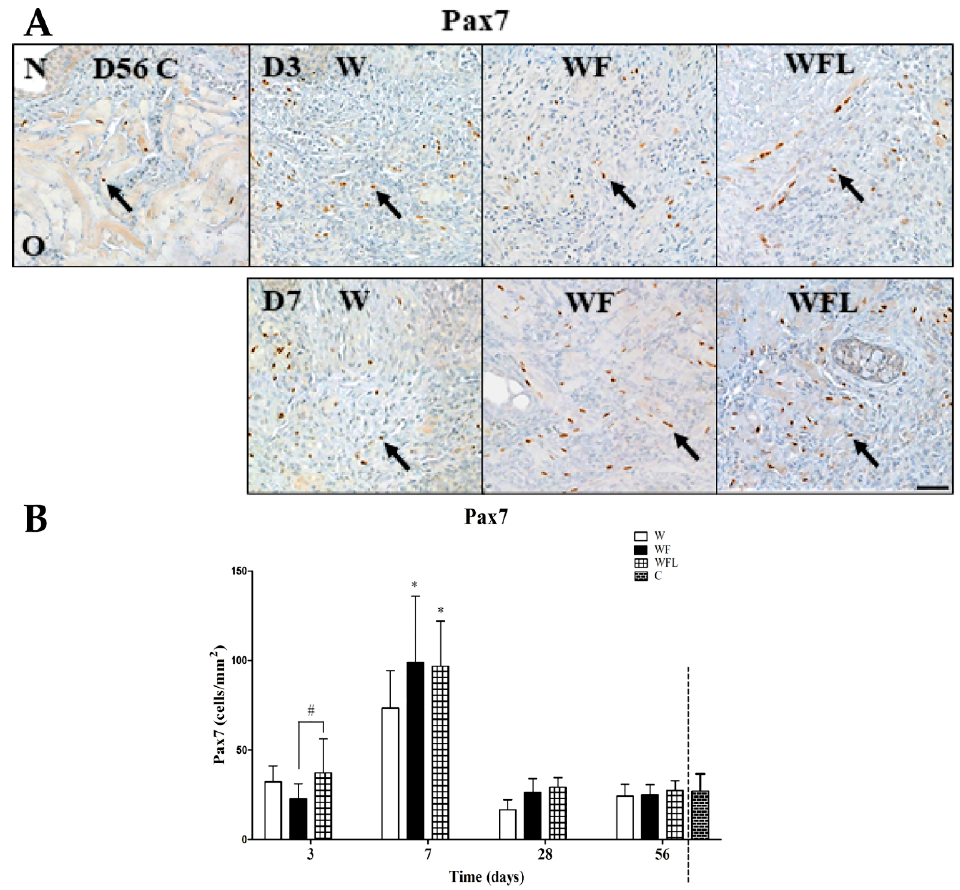
Figure 7. Pax7 immunostaining. ( A ) Representative images at days 56 (age control; D56), 3 (D3) and 7 (D7). Pax7 (brown, arrows) is mostly observed in the wounds treated with fibrin-only and fibrin plus laminin-nidogen at day 7. N: nasal side of the soft palate. O: oral side of the soft palate. Scale bar 50 μ m. ( B ) Quantification of SCs. The Pax7 expression increases from day 3 to 7 in all experimental groups and had decreased by days 28 and 56 ( p ˂ 0.05). At day 56 there were no differences with the age control. Data are shown as mean ± SD. The experimental groups were compared in time using a two-way ANOVA and a Bonferroni post-hoc test. Asterisks (*) indicate significant differences with the control wounds ( p ˂ 0.05). Hash (#) indicates significant differences between fibrin-only and fibrin plus laminin-nidogen ( p ˂ 0.05). Comparisons between experimental groups and the age control at day 56 were made using a one-way ANOVA and a Bonferroni post-hoc test.